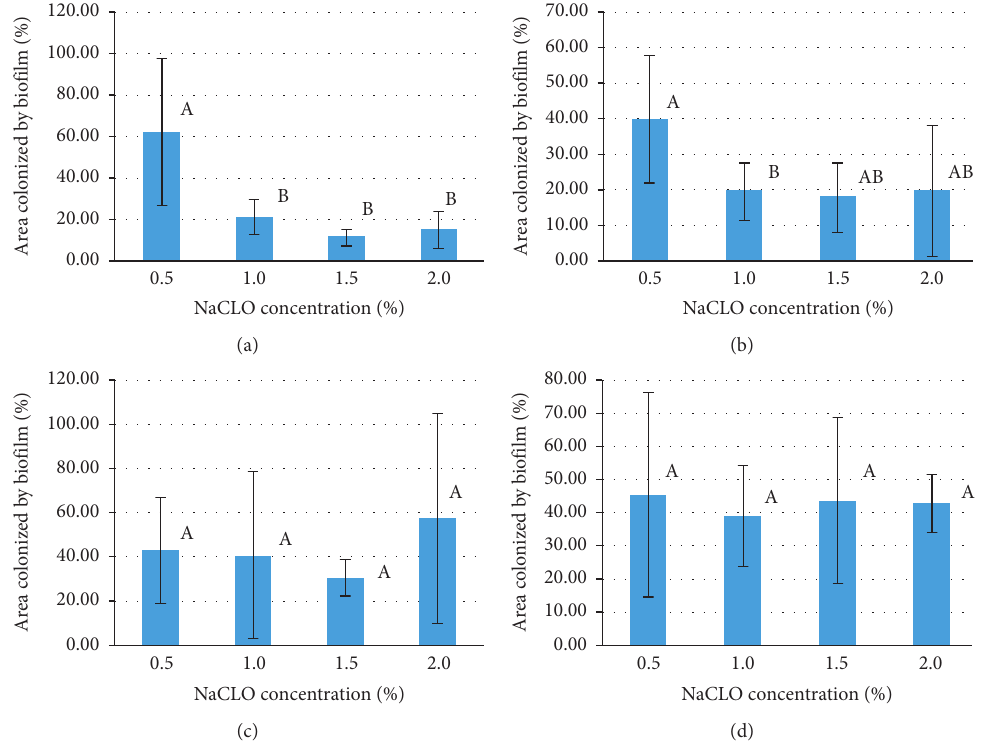
Figure 9: The area colonized by P. aeruginosa on the granite Rosa Porrino (in percentage) after 5 (a), 10 (b), 15 (c), and 30min (d) of NaCLO treatment.